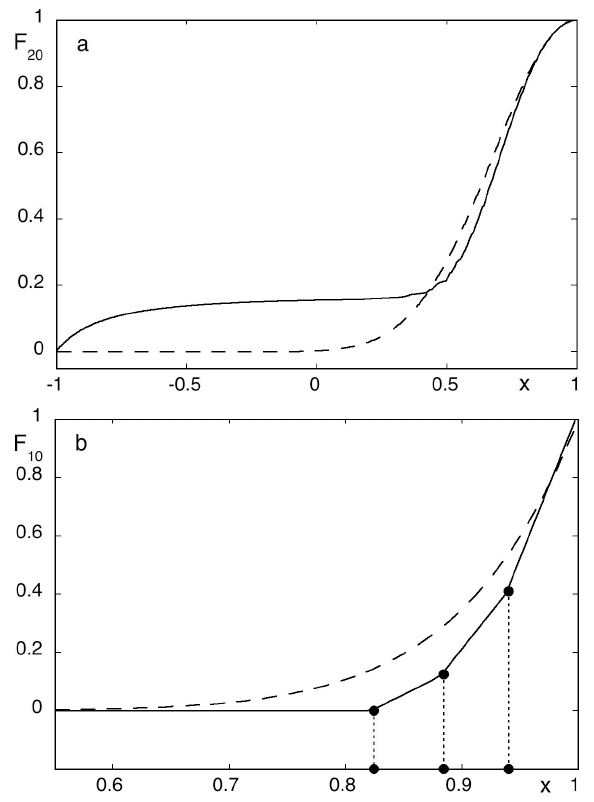
Fig. 4. Cumulative probability distribution F(x) of extremes (solid lines) for two deterministic dynamical systems. (a) For a discrete-time dynamical system that gives rise to intermittent behavior; and (b) for a uniform quasi-periodic motion described by two incommensurable frequencies. In panel (b), the number of slope changes in F is indicated by vertical dotted lines and equals 3; dashed lines in both panels stand for the prediction of classical EVT theory. From Nicolis et al. (2006).